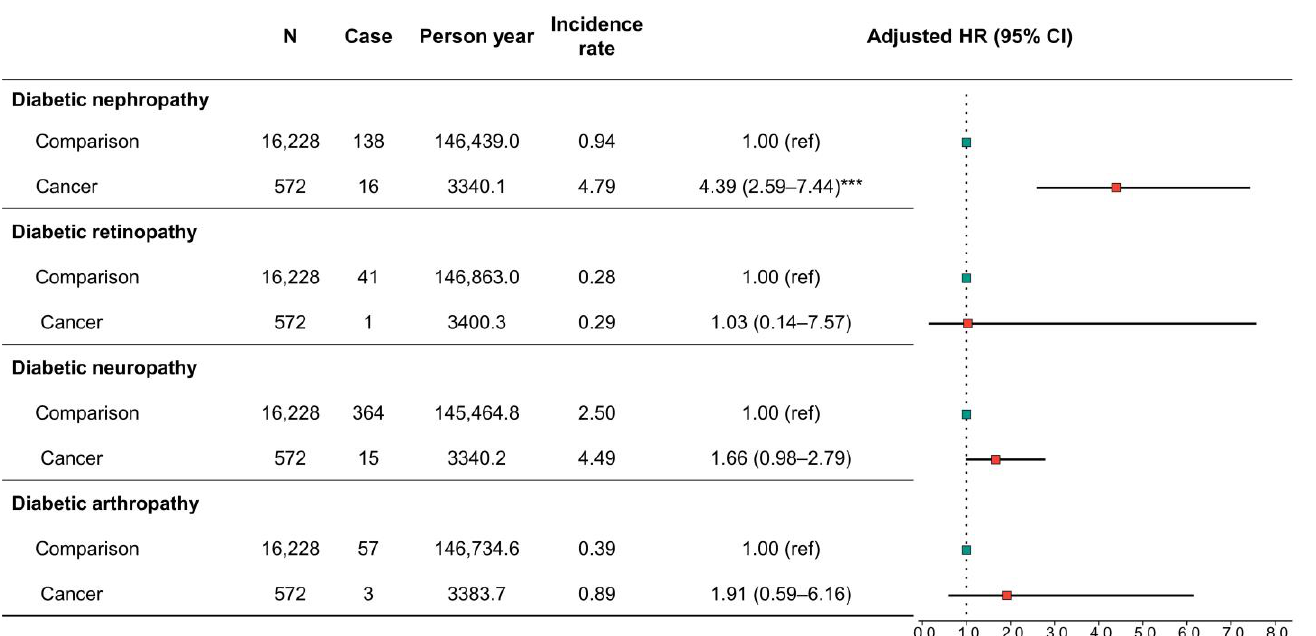
Figure 7. Subgroup analysis for incidence and risk of specific diabetes-associated complications in patients with specific cancer (pancreas, bladder, and prostate). *** p < 0.001. patients with specific cancer (pancreas, bladder, and prostate). *** p <